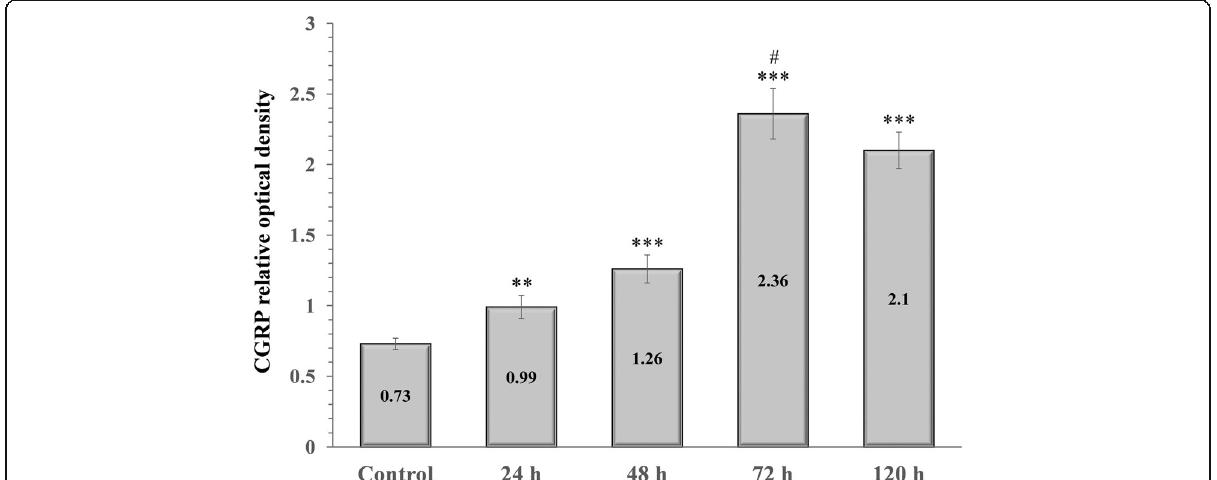
Fig. 3 Relative optical density of the CGRP protein in the TNC following orofacial CFA treatment. *** p < 0.001 vs. Control group, ** p < 0.01 vs.